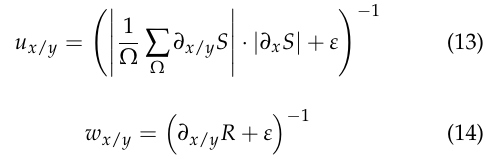
Fig. 2 show the original infrared heat map, the illumi- nation component estimators and reflection component estimators respectively solved by the algorithm in this pa- per. It can be seen that the illuminance component presents the brightness information of the image and represents the gray difference between adjacent pixels, with high esti- mation accuracy. The reflection component represents the structural characteristics of the object, as well as the texture details of the